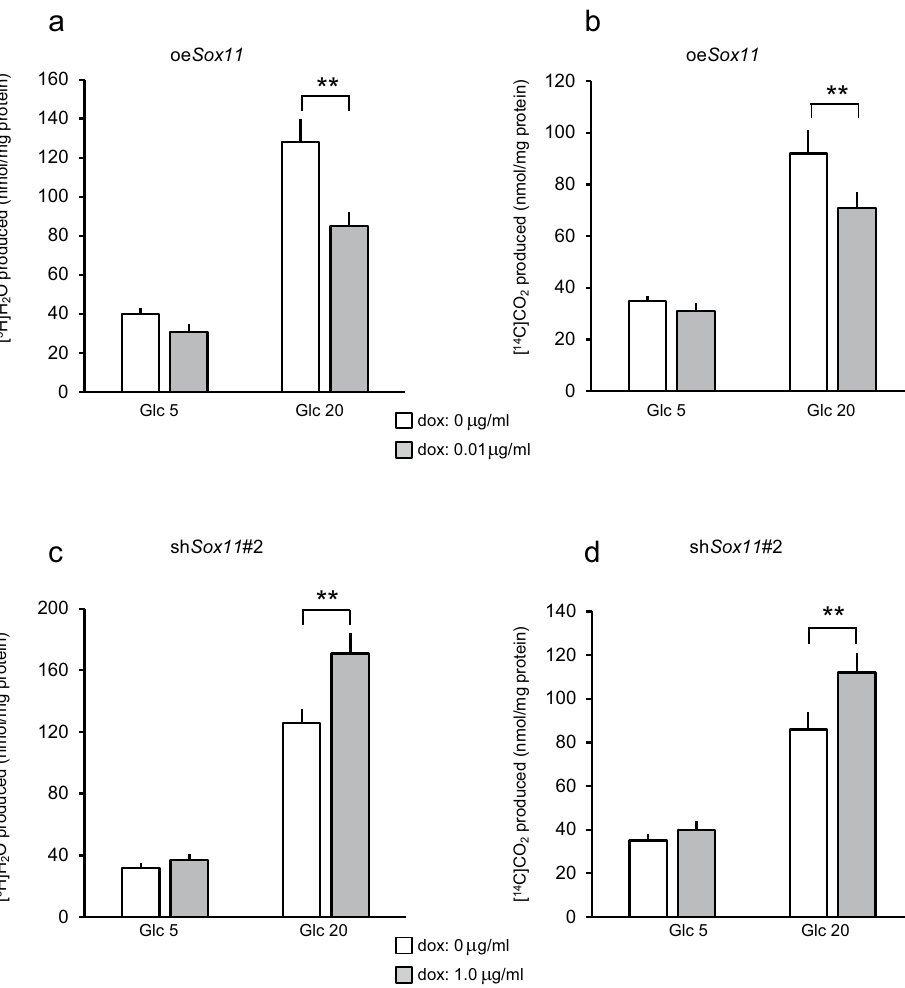
Figure 6. Effects of overexpression or suppression of Sox11 on glucose metabolism. ( a , b ) Glucose utilization estimated using [5- 3 H]glucose ( a ) and glucose oxidation estimated using [U- 14 C]glucose ( b ) in cells with Sox11 overexpression (oe Sox11 ). White bars represent dox-untreated control cells and grey bars dox (0.01 μg/ml)- treated shRNA expressing cells. Data are means ± SEM, n = 3 experiments. ** P < 0.01. ( c , d ) Glucose utilization ( c ) and glucose oxidation ( d ) in cells with Sox11 suppression. Results of Sox11 suppression are presented in cells expressing sh Sox11 #2. White bars represent dox-untreated control cells and grey bars dox (1 μg/ml)-treated shRNA expressing cells. Data are means ± SEM, n = 3 experiments. ** P <